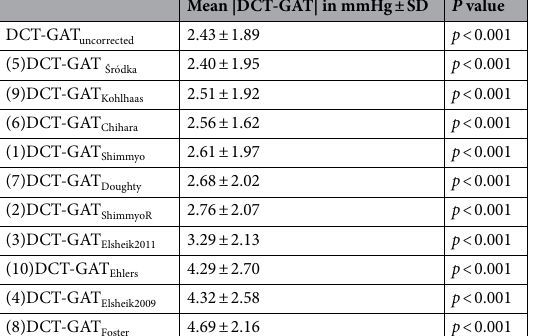
Table 3. DCT and GAT (corrected with different formulas) differences expressed in absolute value in mmHg. DCT Dynamic contour tonometry, GAT Goldmann applanation tonometry, SD Standard deviation, p Level of significance according to paired T-test.